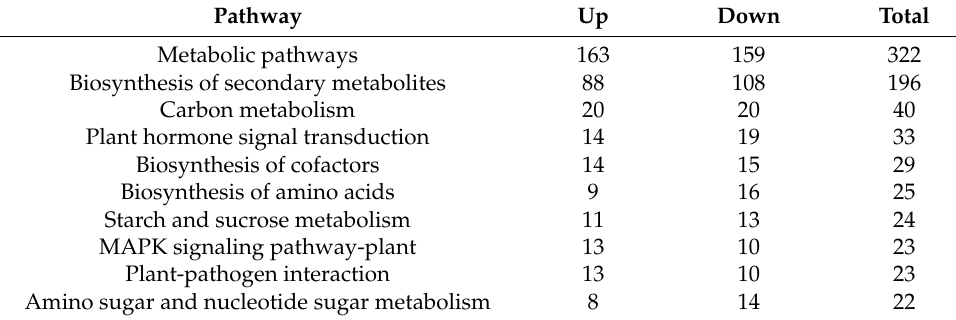
Table 6. Top 10 pathways enriched in the “MgO7d vs. MgO7d + FOL21d” group. Pathway Up Down Total Metabolic pathways